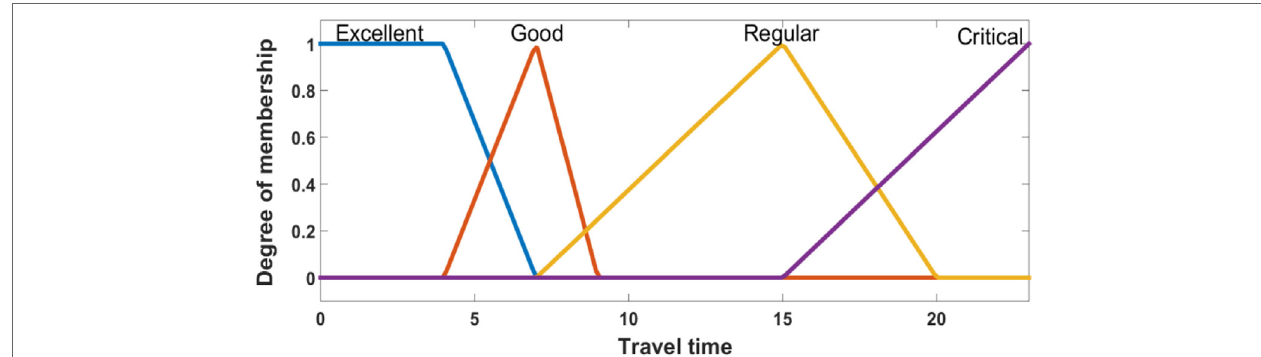
FigUre 6 | Membership functions of travel